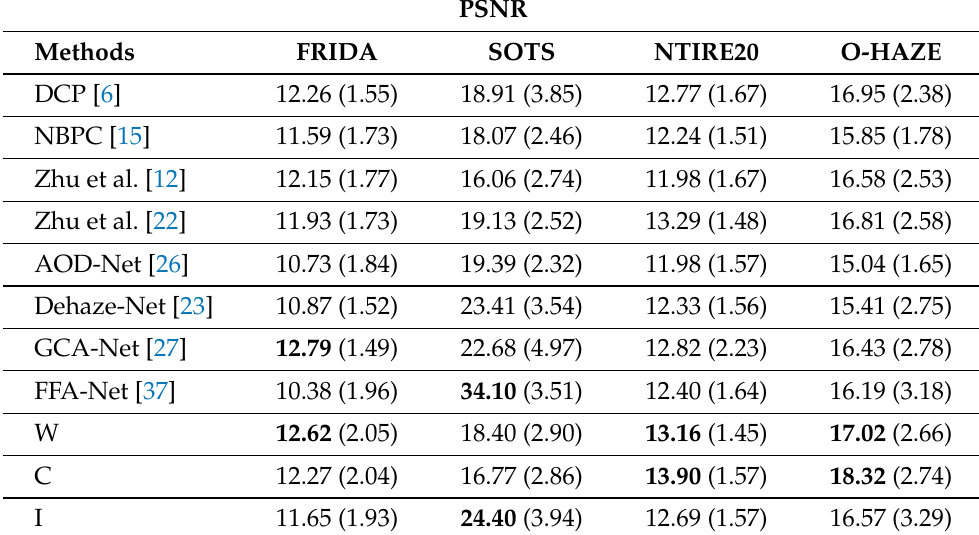
Table 2. Comparison of the PSNR index on four datasets: fifty images from the FRIDA and the SOTS datasets and forty-five images from the NTIRE20 and the O-HAZE datasets. W corresponds to our main algorithm assuming white fog, and C is the color version (see Section 3.6), and I the interpolated version (see Section 3.5). The best results are in bold.